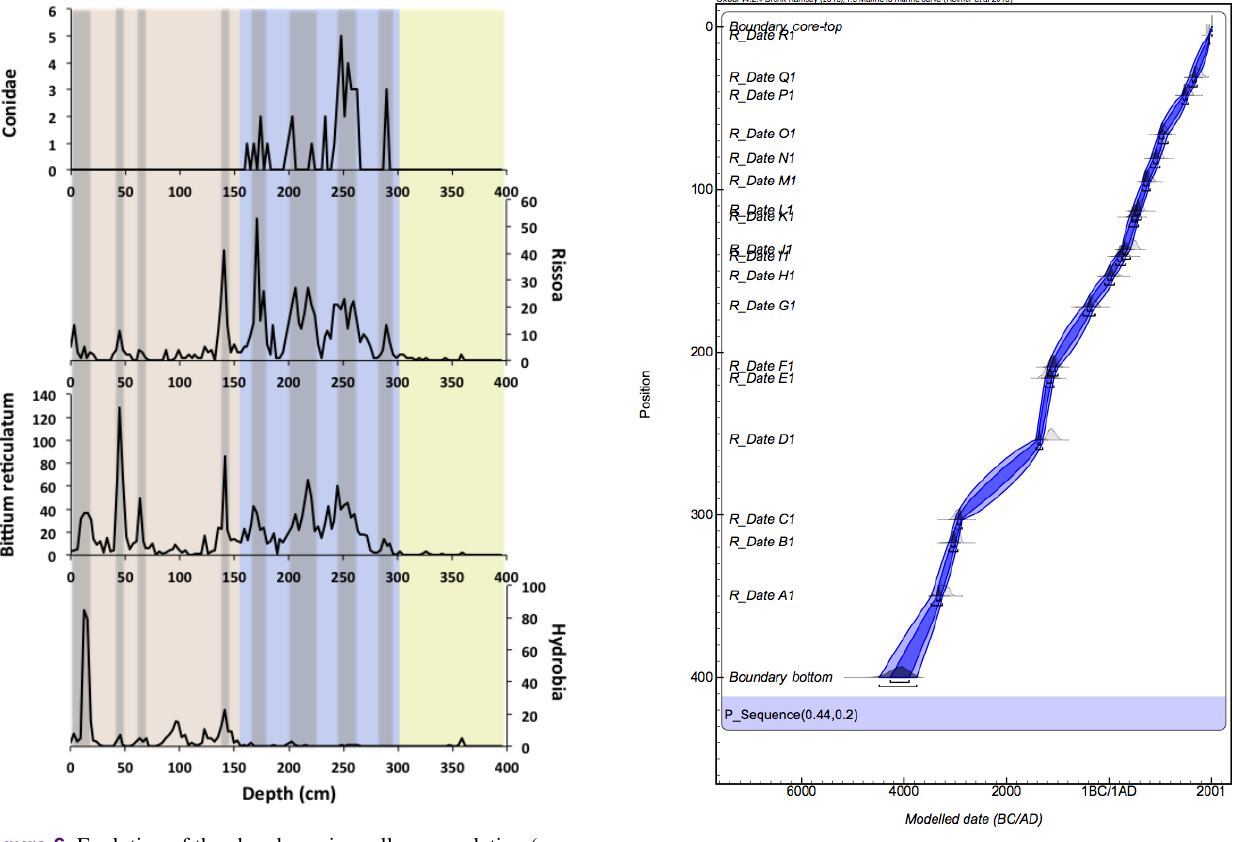
Figure 7. Age vs. depth for the core MM2. The age model was calculated using OxCal 4 with 17 14 C